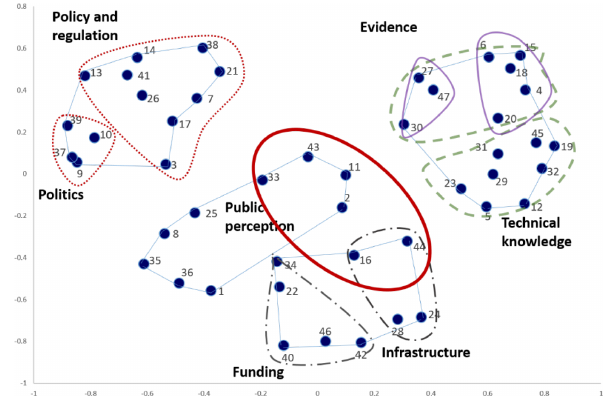
Figure 5. Bridging statements reveal barriers that require an inte- gration of